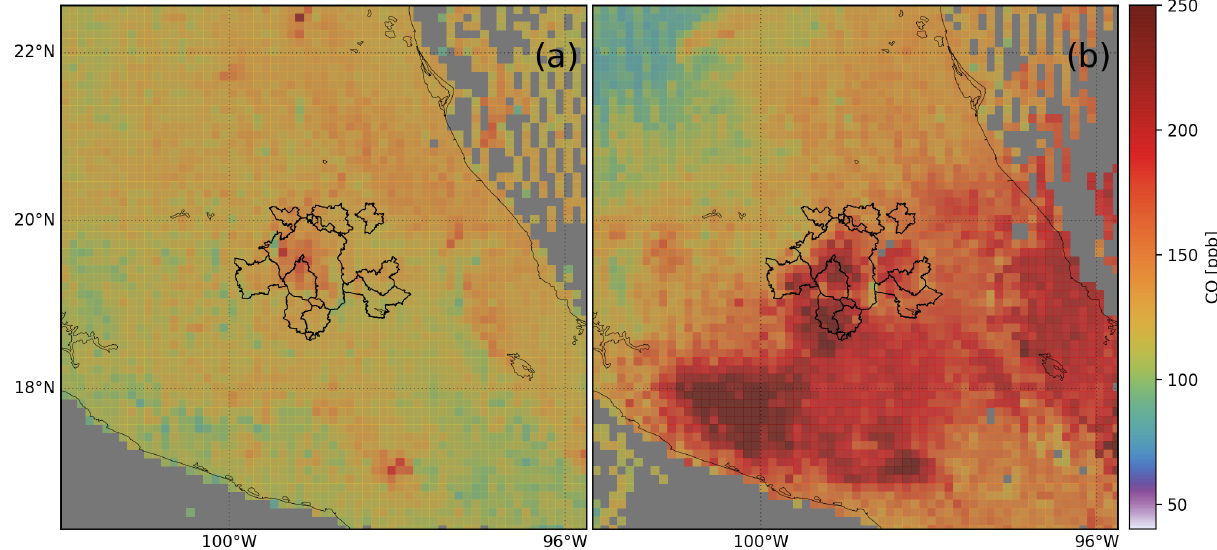
Figure 3. TROPOMI CO data over Mexico City averaged on a 0.1 by 0.1 ◦ lat–long grid. (a) Averaged from 12 to 18 April 2019 showing undisturbed background CO levels. (b) Averaged from 12 to 18 May 2019 showing high CO concentrations in Mexico City caused by fires in the southeast. The street map in the background is under copyright © 2009 ESRI, AND, TANA, ESRI Japan,